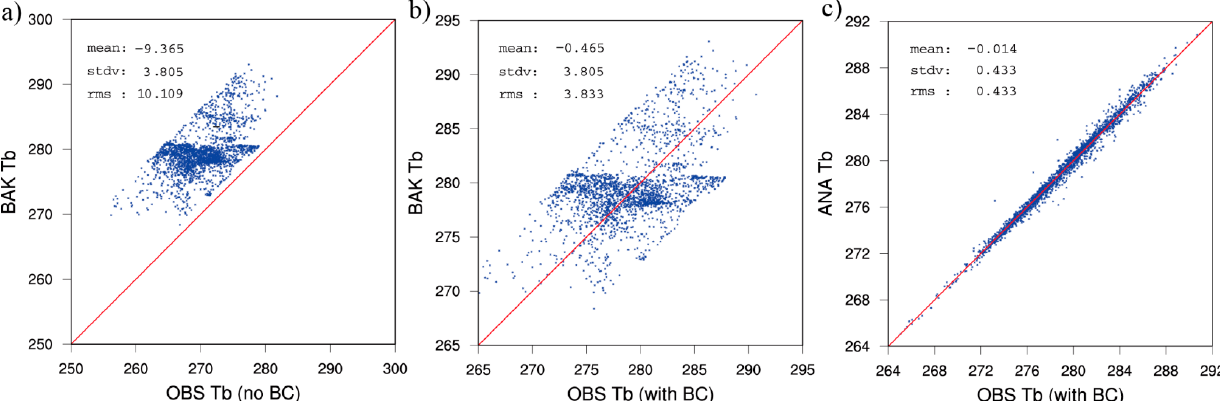
lated Tb based on the background, while the difference between the observation and the